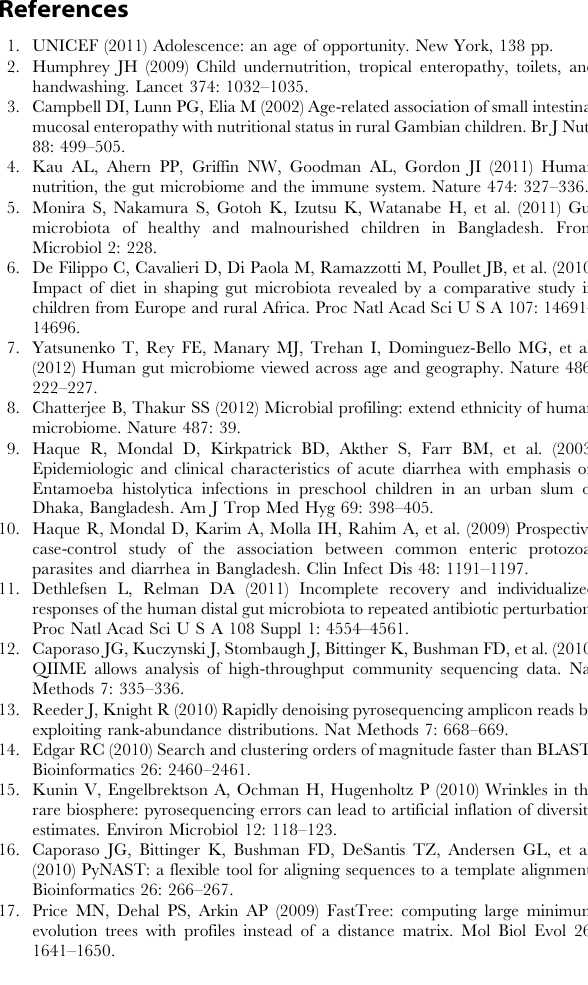
shi child 13F. (C) The average pairwise weighted UniFrac distance between filtered, near full-length and V1–V3 data from the same sample was quantified. This average distance was compared to the average distance between either V1–V3 or filtered near full-length data from different samples of the same individual. The mean weighted UniFrac distance is shown 6 SEM, and p-values were calculated by a two-tailed t-test with unequal